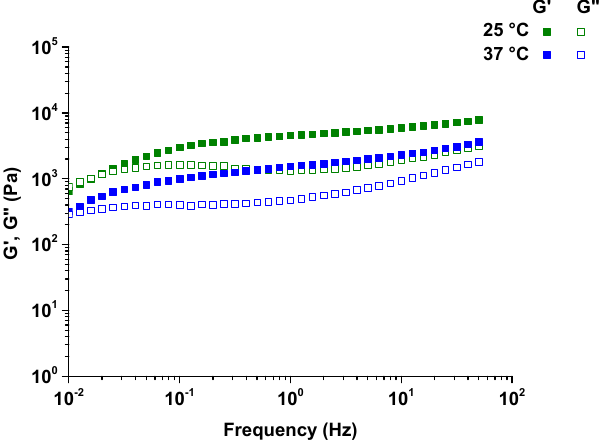
Figure 7. Frequency sweeps performed from 0.01 to 50 Hz of oscillation strain at 25 and 37 °C on hydrogels prepared with 10% P-10K and 10% α -CD.